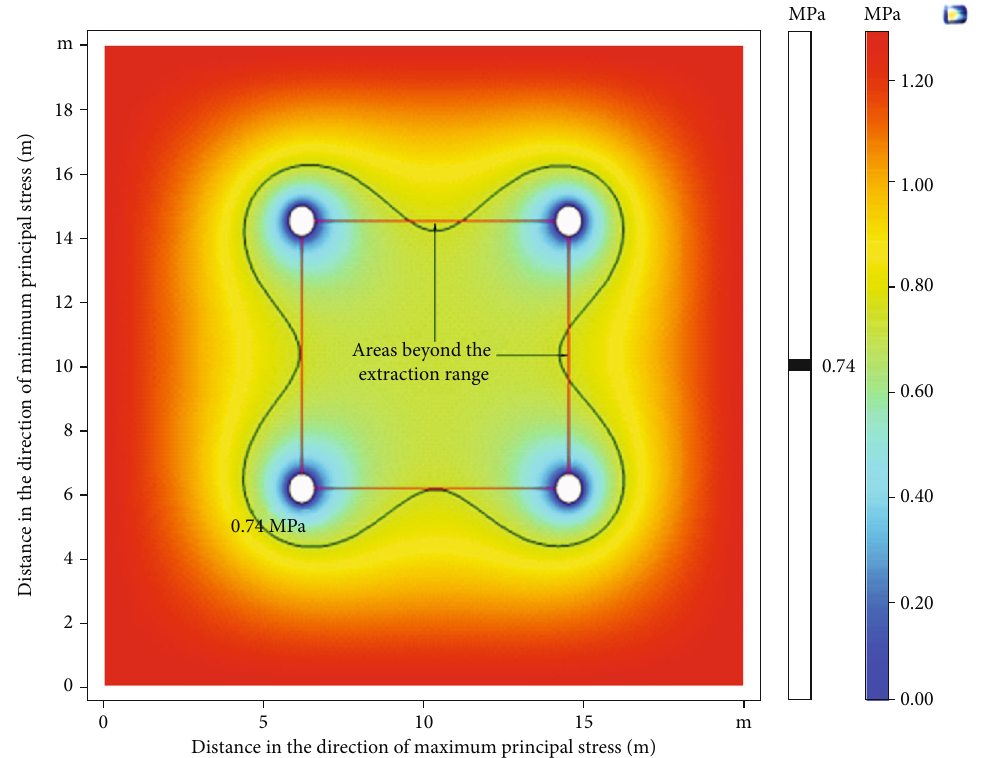
Figure 13: Gas stress distribution map of the minimum horizontal section of the holes that are equivalent to an